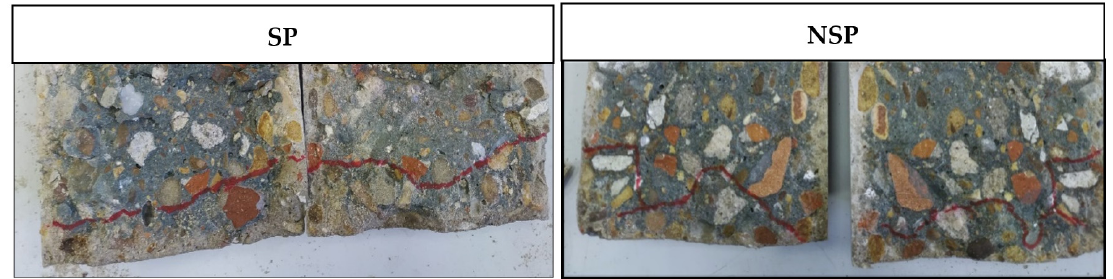
Figure 7. Examples of penetration fronts in SP and NSP specimens after the water under pressure test.